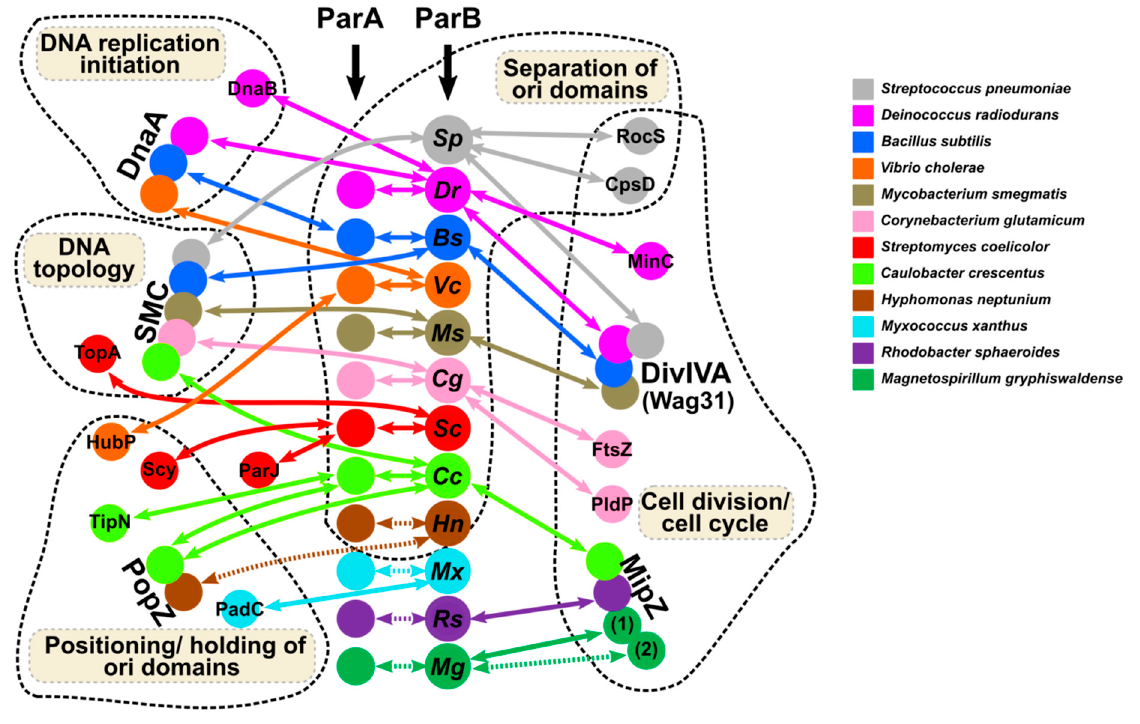
Figure 4. Network of ParBs interactions with ParAs and other partners coordinating chromosome segregation with various cellular functions in the analyzed bacterial species. The dashed arrows indicate interactions not yet confirmed experimentally.